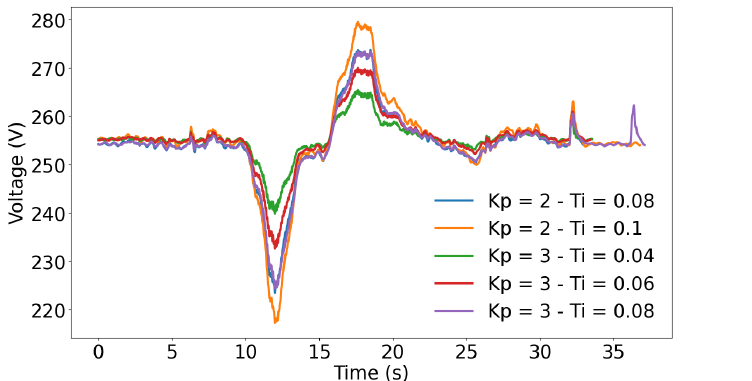
Figure 24. System voltage disturbance simulated for Cloud 2 with different PI